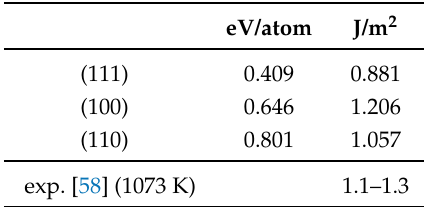
Table 2. Our computed surface energies for Ag surfaces with different crystallographic orientations in comparison with available experimental data